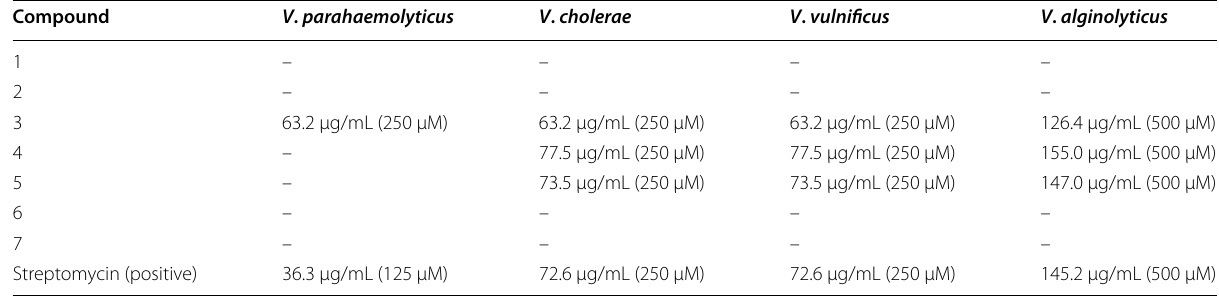
Table 1 The MIC of anti- Vibrio activities of compounds 1–7 Compound